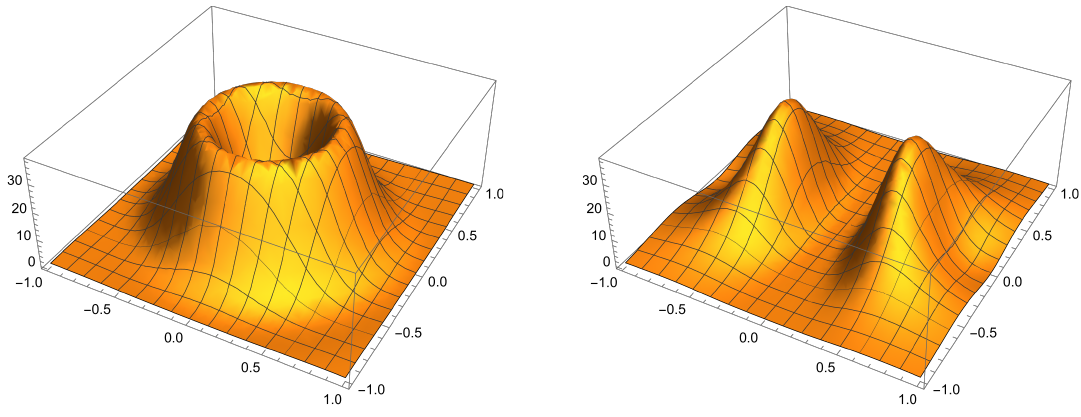
Figure 3 . The density of the (2,3) fluid as a function of ( x, y ) for z = 0 left and of ( x, z ) for y = 0 on the